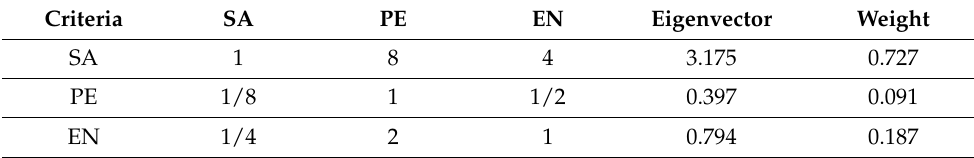
Table 6. Criteria comparison matrix